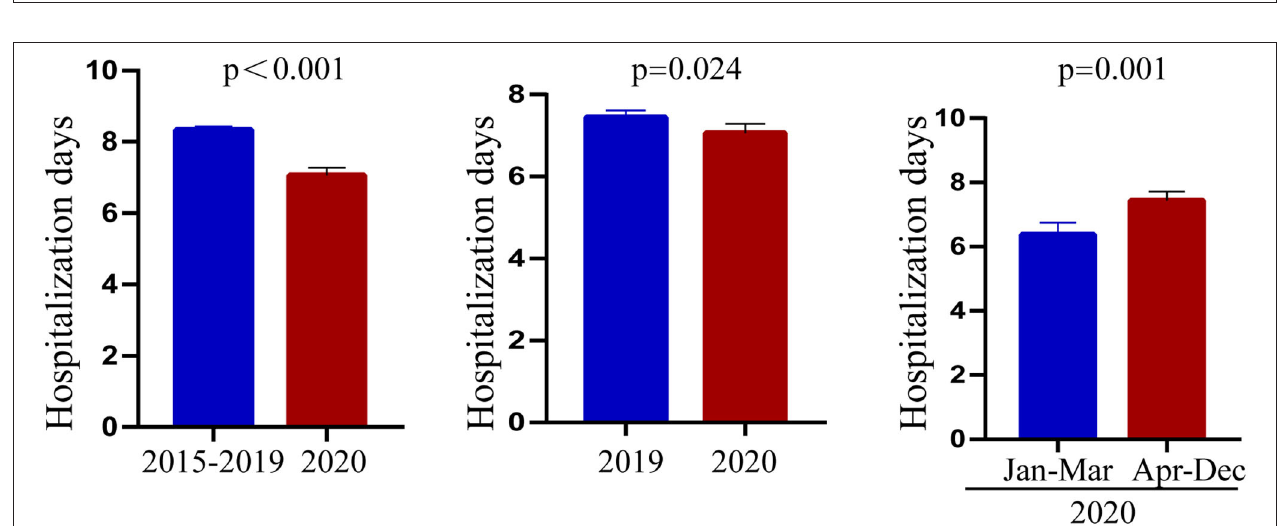
FIGURE 1 | Characteristics of ages before and after the COVID-19 pandemic.